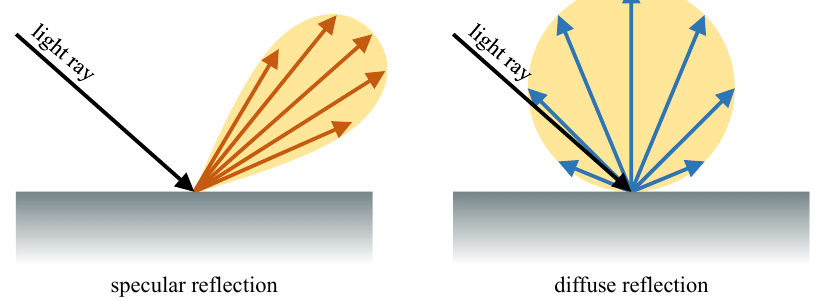
Figure 2. Differences between the specular and diffuse reflections: specuclar reflections occur on mirror-like surfaces, while diffuse reflections shows light scattering